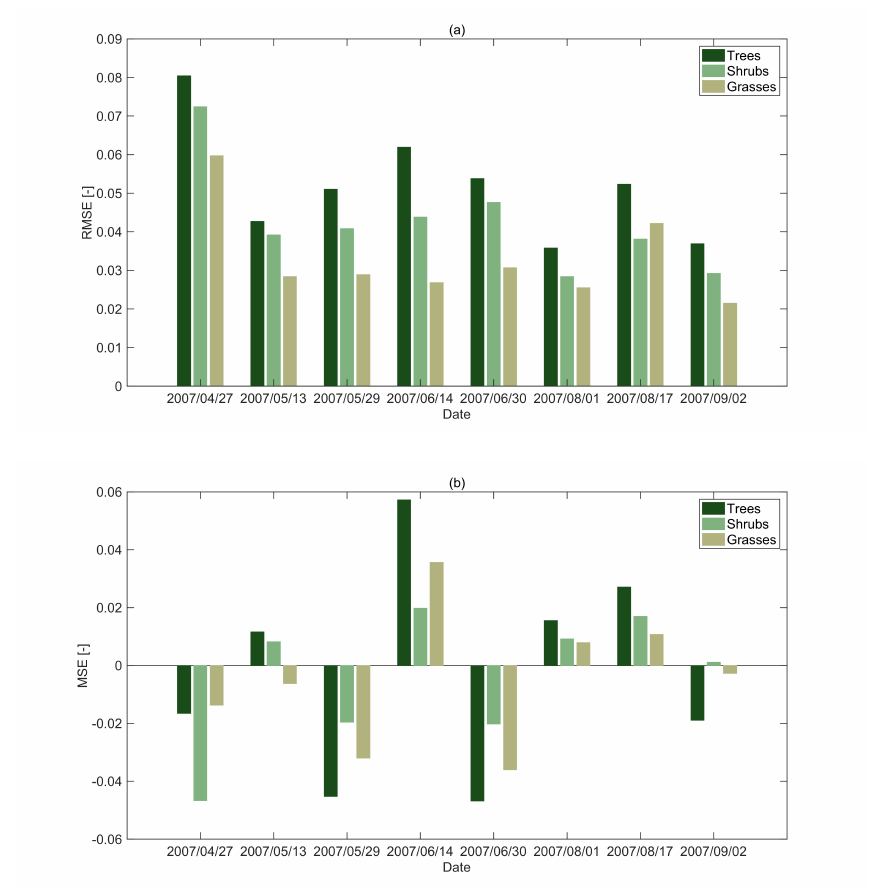
Figure 3. Root mean square error (RMSE) ( a ) and mean signed error (MSE), ( b ) separated by dominant vegetation functional type over the 2007 growing season at Dry Creek Experimental Watershed (DCEW), Idaho,